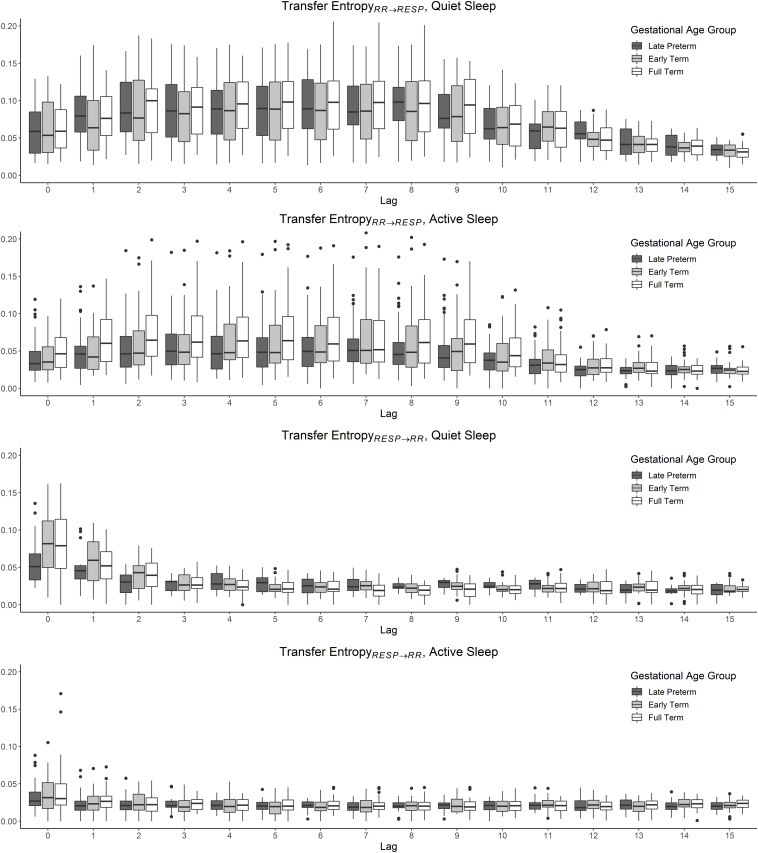
TE estimates computed for cardiorespiratory dataset considering the three GA groups: LPT, ET, and FT, separately for QS and AS. The behavior of TERR→RESP resembles a longer and stable effect of RR modulation over RESP. On the contrary, TERESP→RR exhibit a transient and rapidly decreasing interaction between the subsystems.